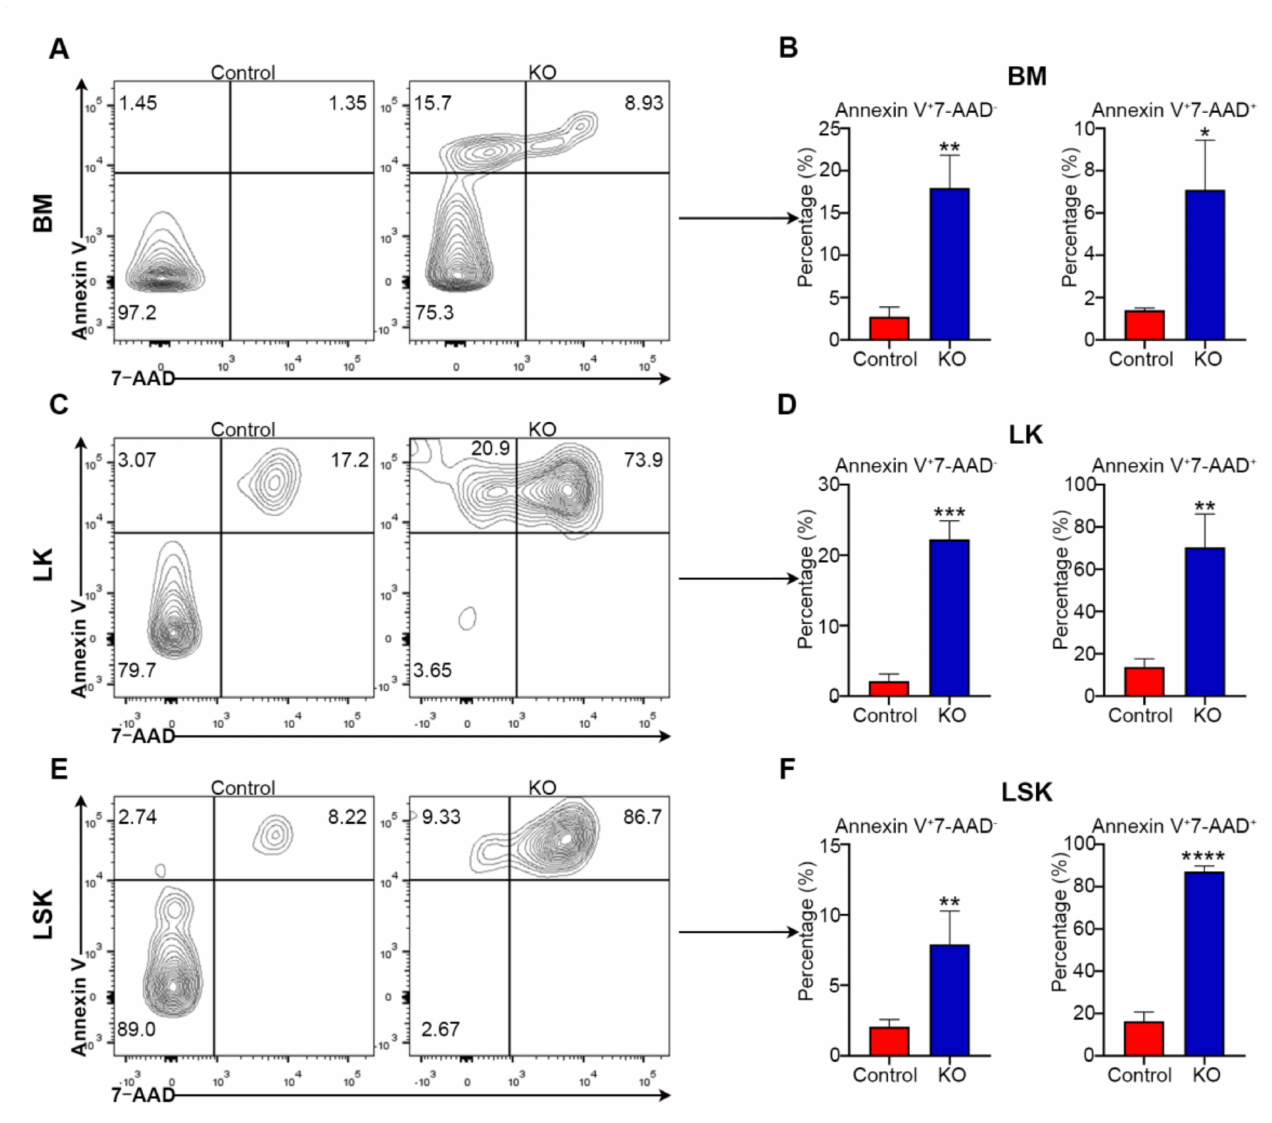
Figure 5. Loss of Myh9 leads to apoptosis of hematopoietic stem/progenitor cells. Representative dot plots and bar graphs of apoptotic cells from BM ( A , B ), LK ( C , D ), and LSK ( E , F ) cells of control and Myh9 fl/fl :Mx1-cre mice 8 days after first poly I:C injection (n = 3). All data are shown as mean ± SD. Student t test was used to compare two groups of mice (* p < 0.05, ** p < 0.005, *** p < 0.001, **** p <